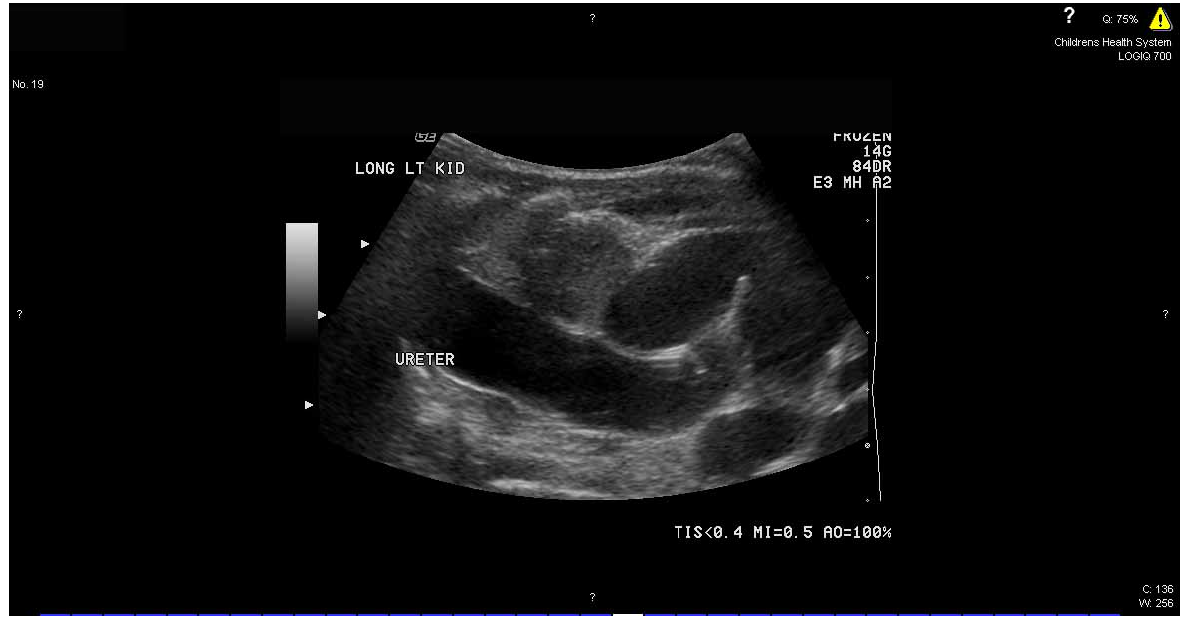
FIGURE 9C . Renal ultrasound demonstrating dilated upper-pole moiety ureter and the absence of parenchyma in the upper pole of the